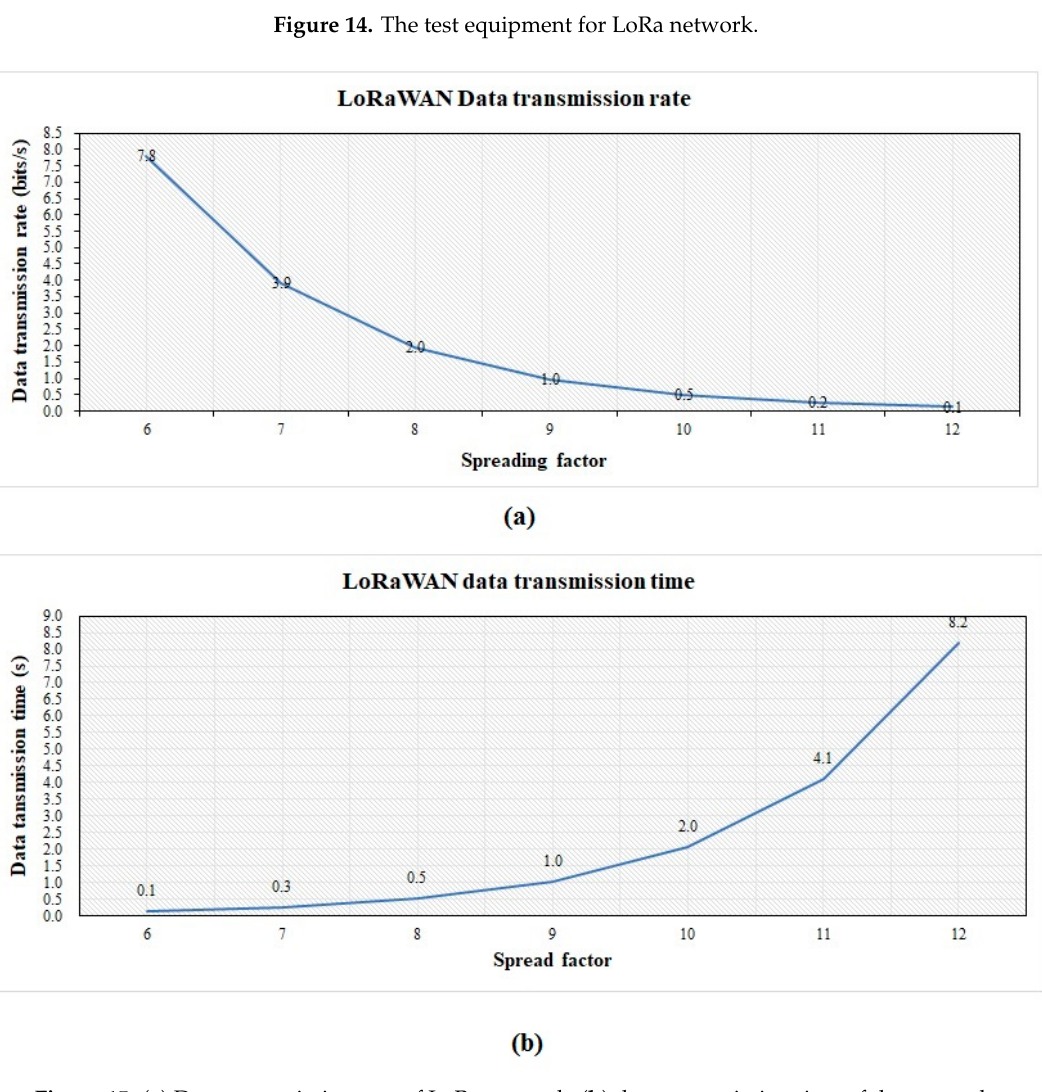
Figure 15. ( a ) Data transmission rate of LoRa network; ( b ) data transmission time of the network.